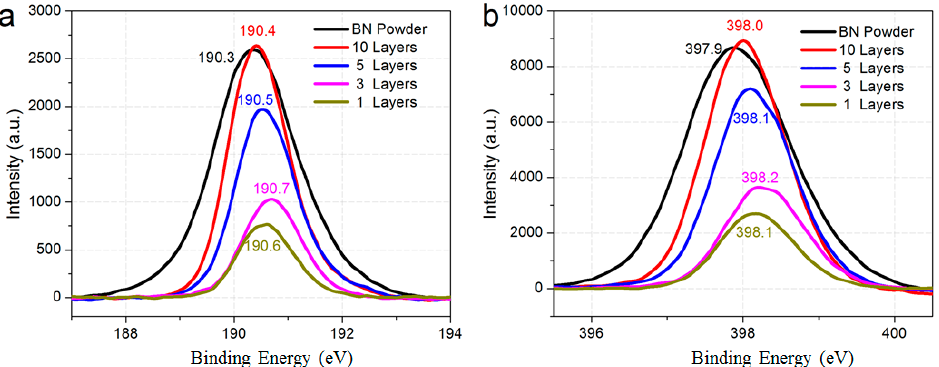
Figure 5. XPS signature of h-BN films. ( a , b ) XPS spectra of B and N 1s core level of samples in various thicknesses.